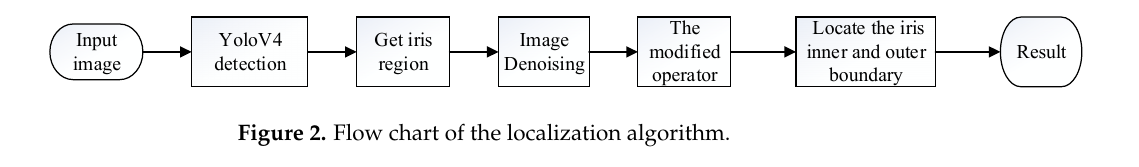
Figure 2. Flow chart of the localization algorithm.